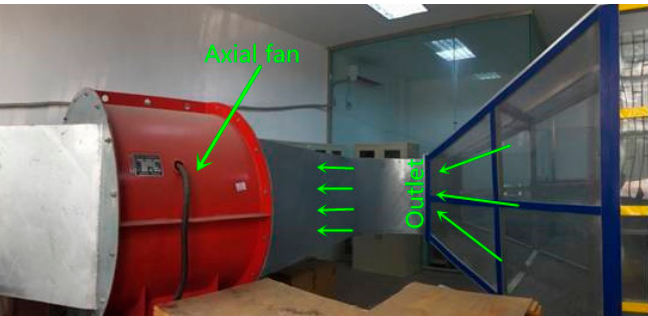
Figure 6. SZ ‐ 11.2axial fan.